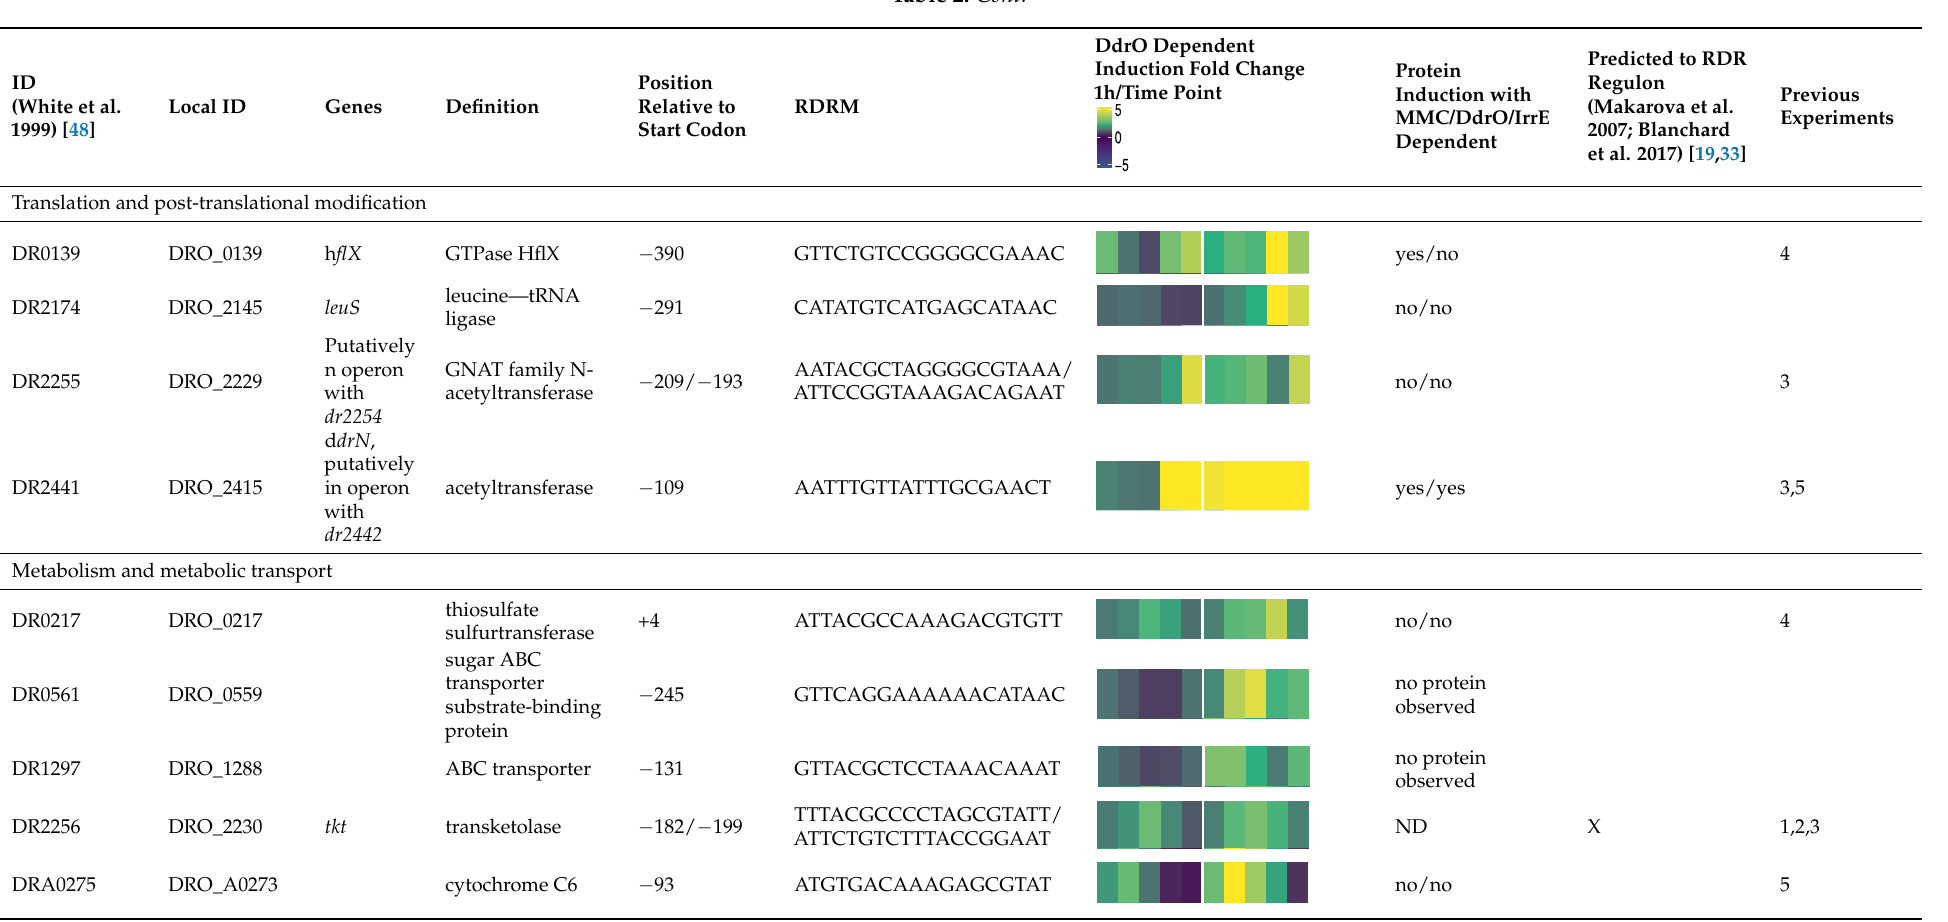
Table 2. List of genes belonging to the DdrO regulon in D. radiodurans matching all criteria (transcriptomic, ChIP-seq, and RDRM). Previous experiments: (1) RDR genes previously predicted by bioinformatic analyses [19,33] (2) by in vitro EMSA assays which analyzed the binding of DdrO to RDRM sequences located in the promoter regions of these genes [26] or shown to be regulated after exposure to radiation by (3) transcriptomic [12], (4) proteomic studies [54], or (5) in a ∆ irrE mutant [24]. Logo of the RDRM consensus performed by MEME from all the RDRM sequences listed in Table 2. ND: Not Table 2. Cont.